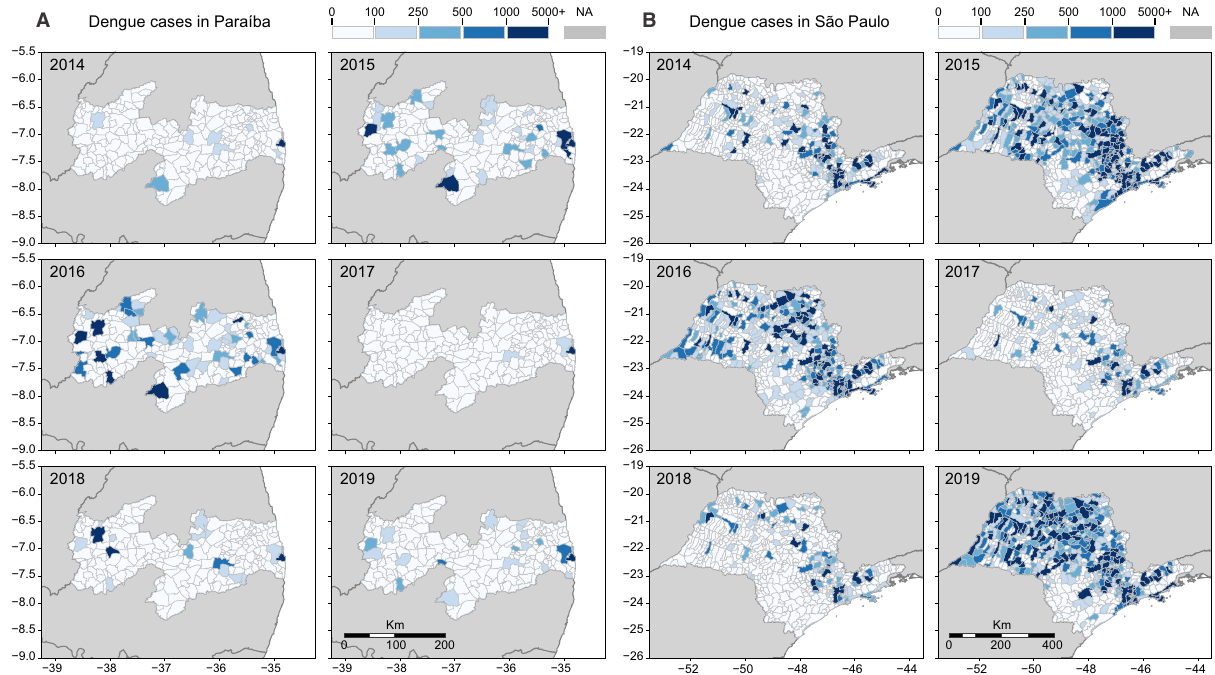
Fig. 2 Reported dengue cases per municipality in Paraíba and São Paulo states, 2014 – 2019. The dynamics of dengue in A Paraíba and B São Paulo between 2014 and 2019 followed similar cyclic patterns observed throughout Brazil: a decline in cases in 2014, followed by 2 years of high incidence (2015 – 2016), succeeded by 2 years of low incidence (2017 – 2018), with a resurgence of dengue in 2019. As in Figs. 5 and 6, the three main cities included in our study are highlighted in each state. In A Paraíba, we show: (1) João Pessoa; (2) Campina Grande; and (3) Coremas. In B São Paulo, we highlight: 1. Ribeirão Preto; 2. Araraquara; and 3. São José do Rio Preto. Normalized dengue incidence per 100,000 population is shown in Fig.